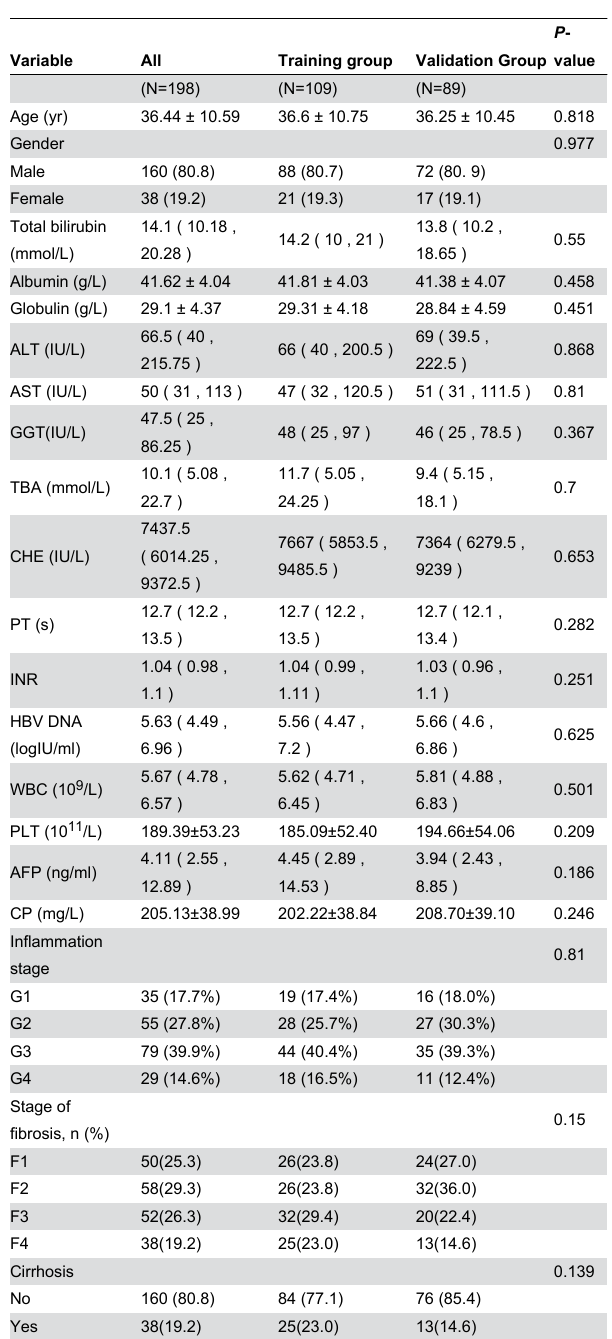
Table 1. Demographic and clinical characteristics of subjects in the training and validation groups.